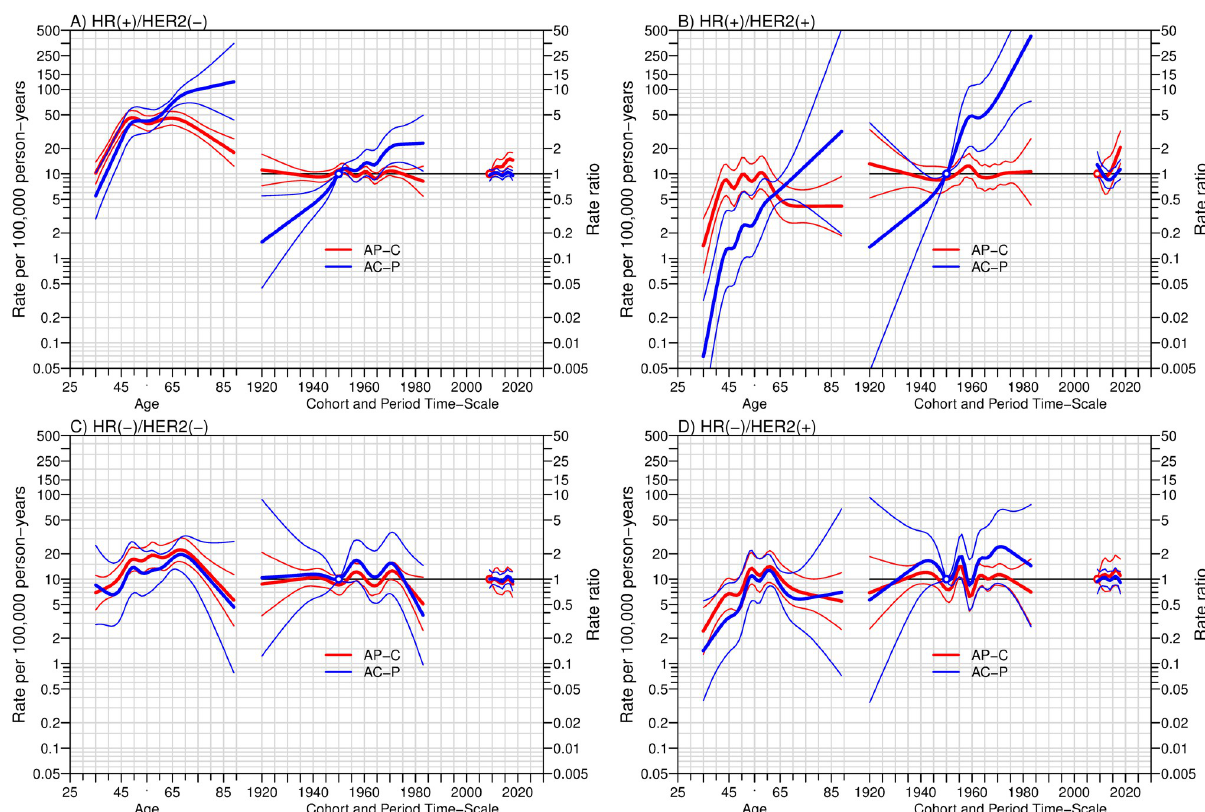
Fig 2. The age-period-cohort (APC) trend analysis of the four breast cancer subtypes according to M-IHC in A, B, C, and D. The three curves in each subfigure, from left to right, represent the incidence rate by age, the rate ratio of incidence by birth-cohort, and year of diagnosis for the reference cohort in blue or reference period in red. The references were the cohort born in 1950 and the diagnosis period of 2009, respectively. Thick lines and the associated thin lines are the three coefficients mentioned previously and 95% confidence intervals. AP-C = Cohort effects modeled with Age-Period component as offset; AC-P = Period effects modeled with Age-Cohort component as offset; HR = hormone receptor; HER2 = human epidermal growth factor receptor